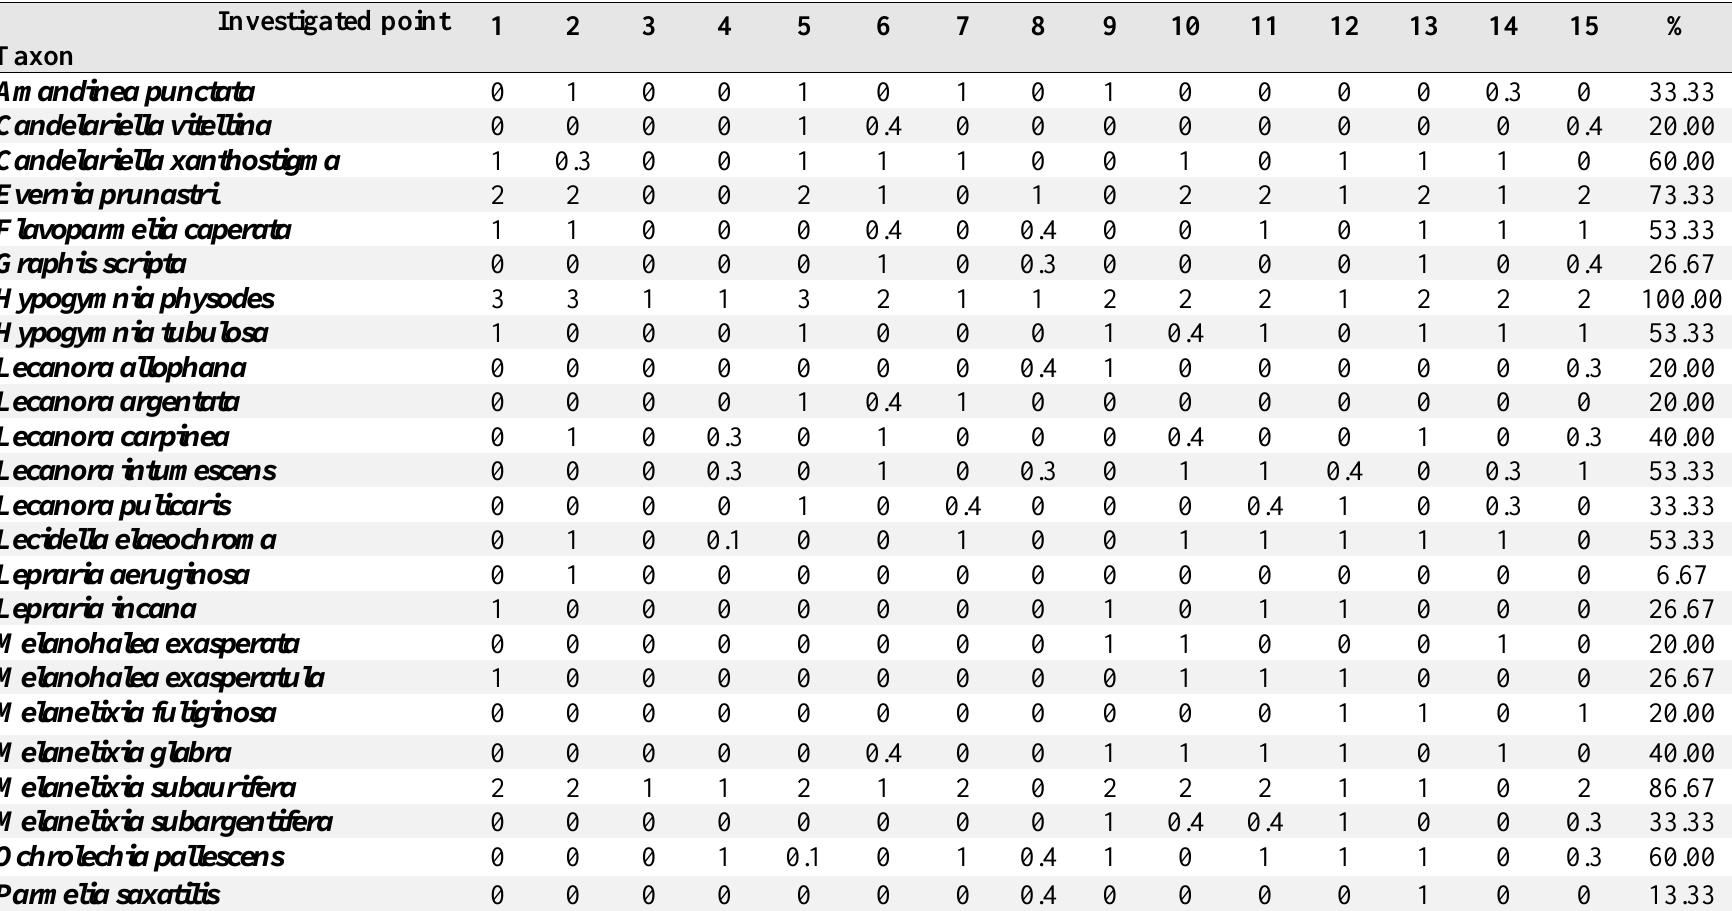
Table 2. Lichen species found on the researched area, the values of the coefficient f , the frequency (%) of each taxon and values of IAP and IHI on each of investigated points in